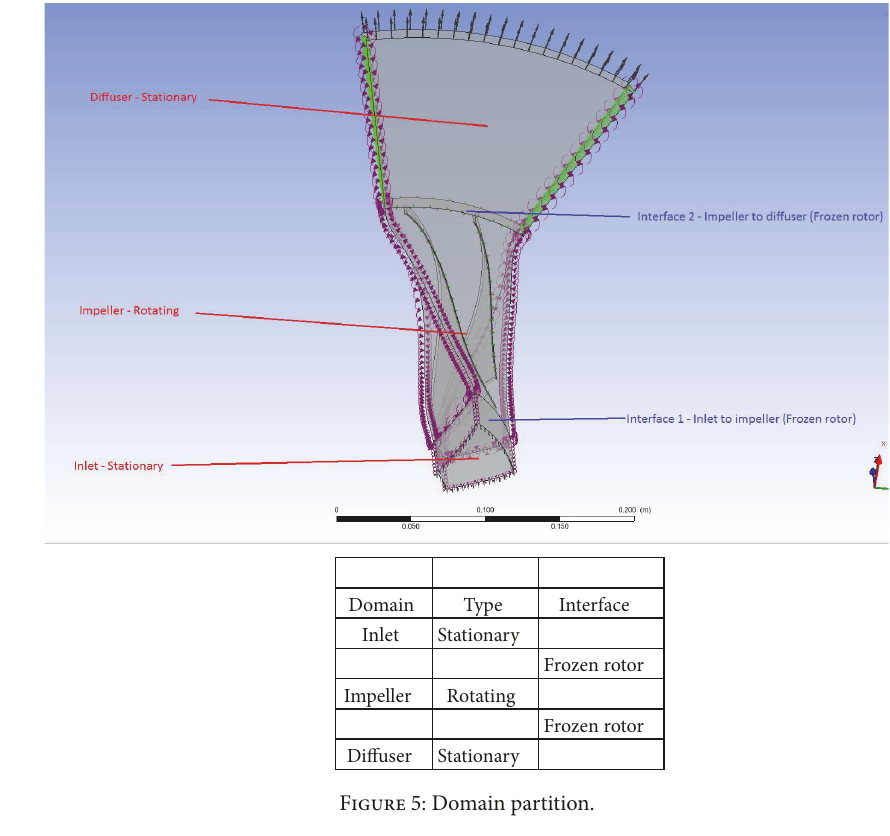
Figure 5: Domain partition.